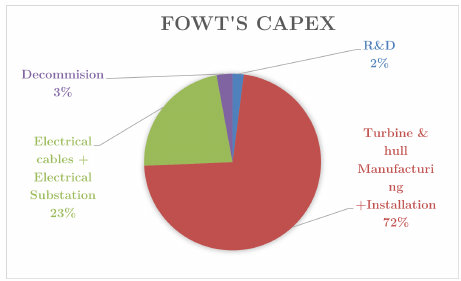
Figure 23. Breakdown cost of FOWT platform.